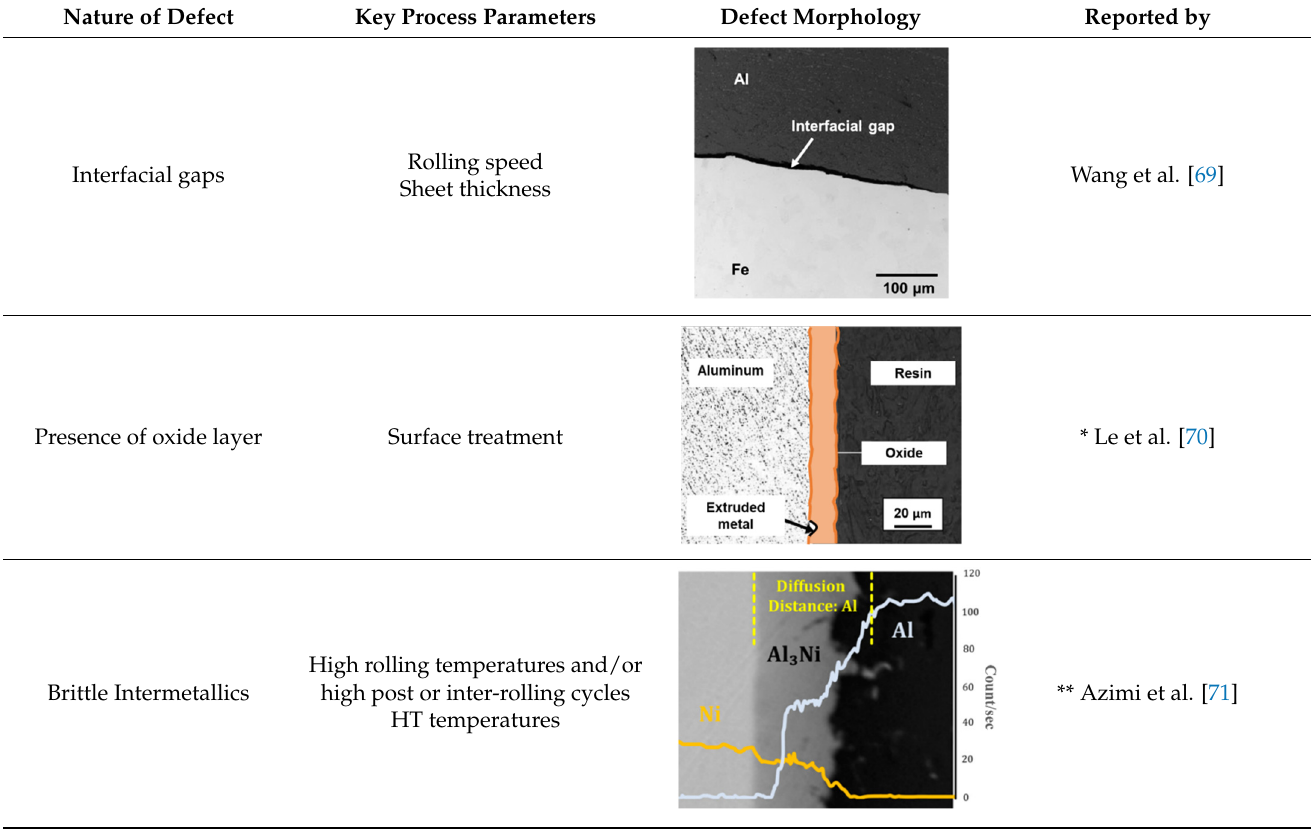
Table 2. Common defects in RB processes.